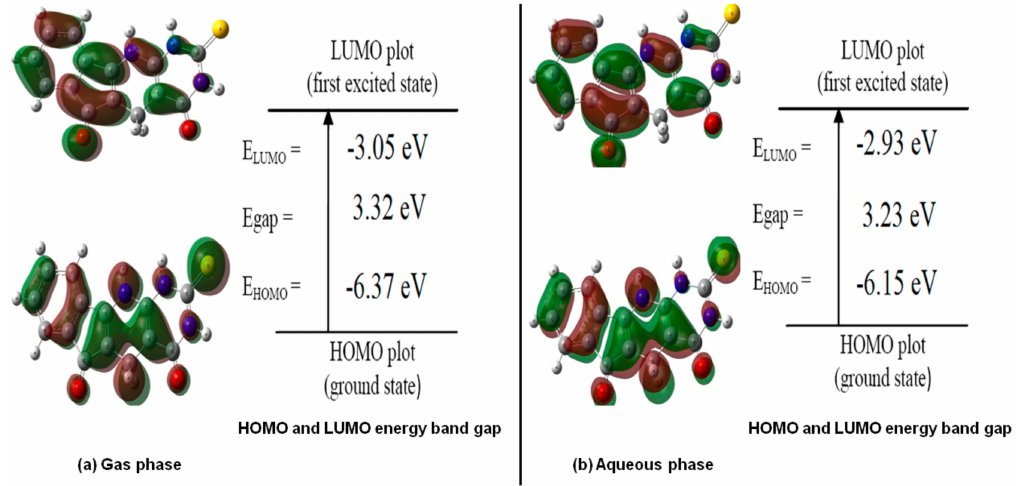
Figure 5. Highest occupied molecular orbital (HOMO) and lowest occupied molecular orbital (LUMO) of compound 1H: ( a ) in gas and ( b ) aqueous